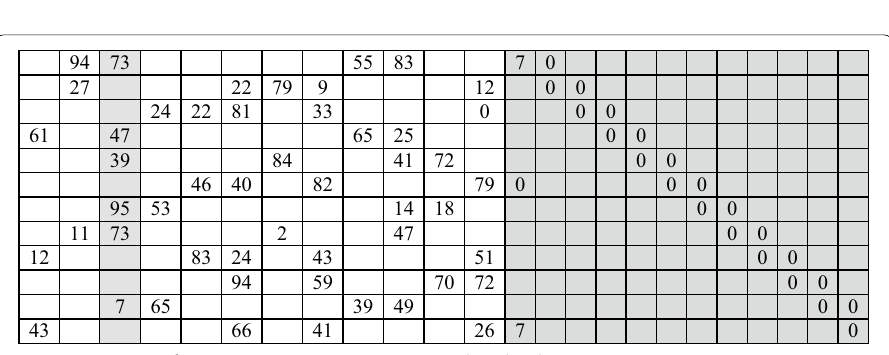
Fig. 1 Base matrices of IEEE 802.15.3c QC-LDPC codes [39]: a (672,336)-LDPC code; b (672-425)-LDPC code; c (672,504)-LDPC code; d (672,588)-LDPC code